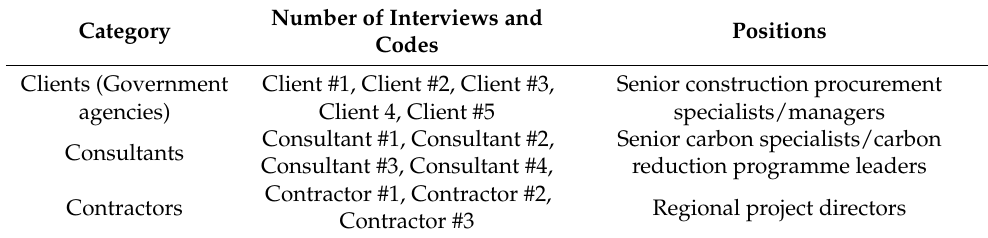
Table 1. Interviewees’